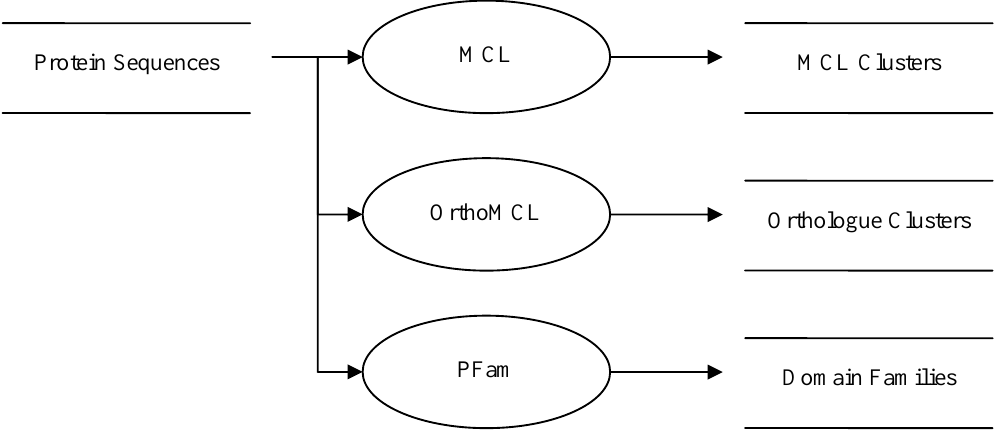
Figure 1: A data flow diagram for sequence clustering and family